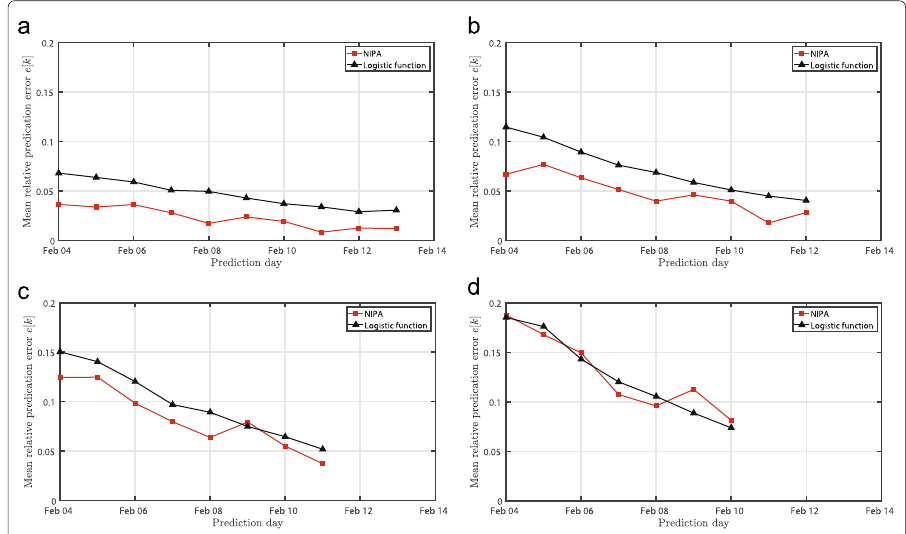
Fig. 4 Prediction error versus number of observed days . The accuracy of both prediction methods for the COVID-19 outbreak versus the date until the data is available. The subfigures correspond to a prediction of : ( a ) 1-day ahead, ( b ) 2-days ahead, ( c ) 3-days ahead, ( d ) 4-days